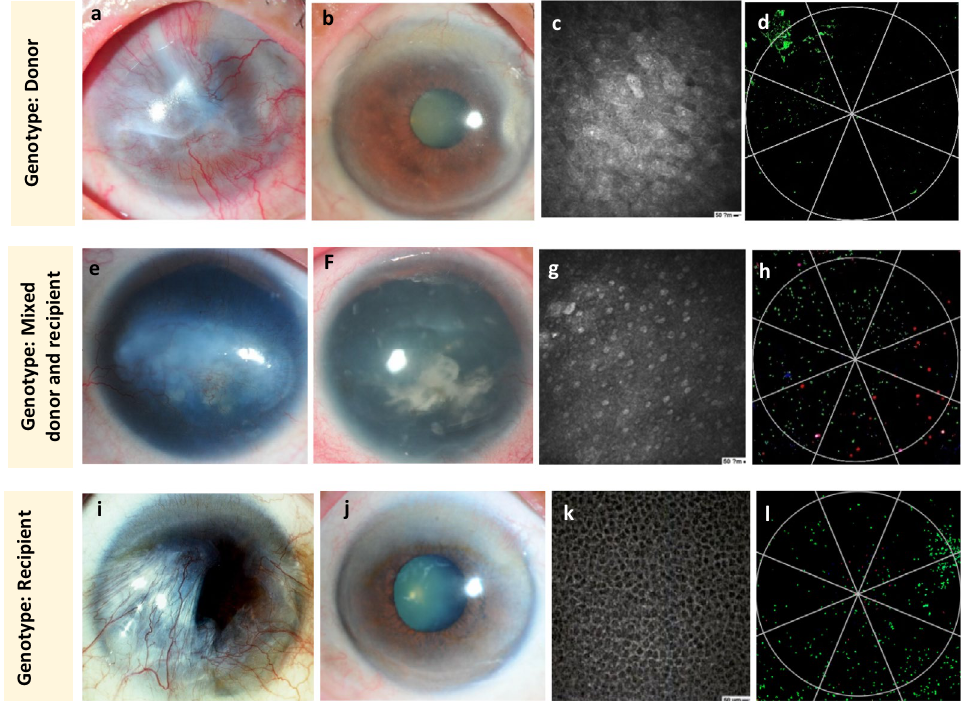
Figure 2. Representative clinical findings of each category of genotypic results by slit-lamp examination. IVCM shows multilayer corneal epithelium or basal corneal epithelium, and IC with immunofluorescence shows total or predominant K12 (CK12 and CK7 stained green and red, respectively) at the central corneal 5-mm zone. The results include donor (patient 3, a – d ), mixed (patient 2, e – h ), and recipient (patient 12, i – l ) genotypes. The images in the left column show the preoperative findings of those patients with total (patient 4, patient 3) and partial (patient 11) LSCD who underwent allo-SLET (patient 4, patient 3) and allo-CLET (patient 11). The images in the other columns show the postoperative findings at the time of genotypic analysis, which show a clear central cornea with the corneal epithelial phenotype in all categories of genotypes.